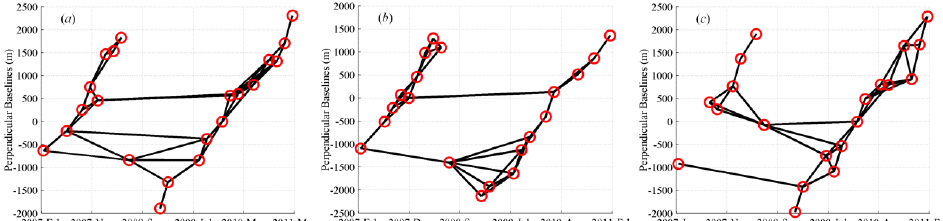
Figure 3. Interferograms used for small baselines analysis ( a ) path 462, ( b ) path 463 and ( c ) path 464. The circles represent the images and solid lines represent the interferograms.